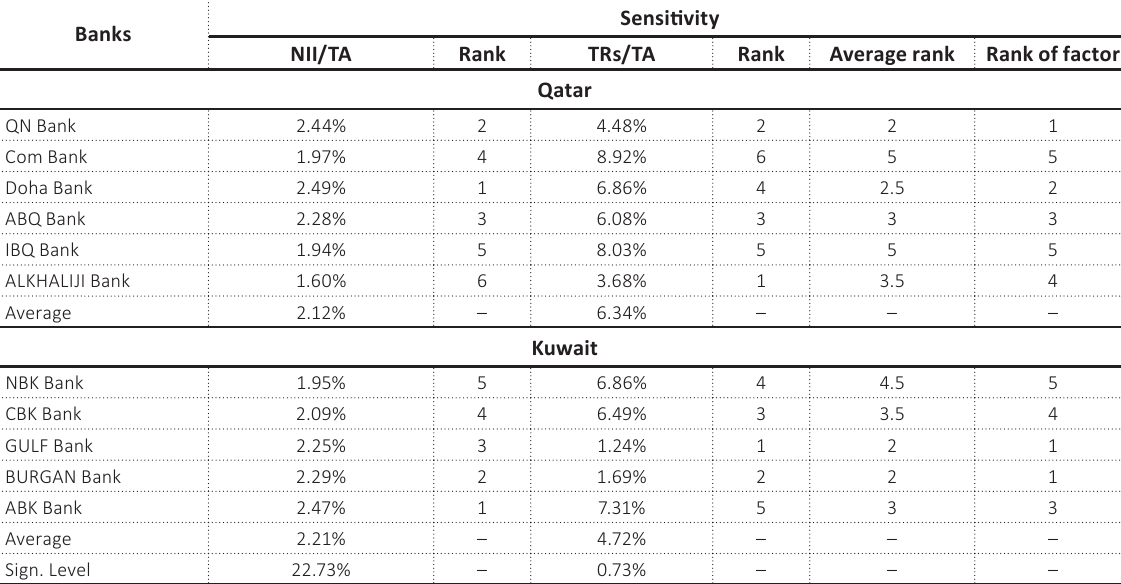
Table 8. Average ratios of years and rankings in the case of the Sensitivity factor at selected